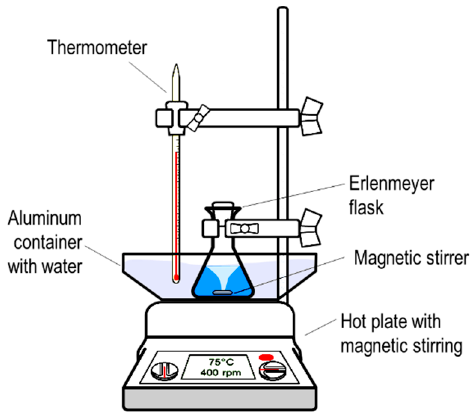
Figure 1. A schematic diagram of the leaching experiment set-up.